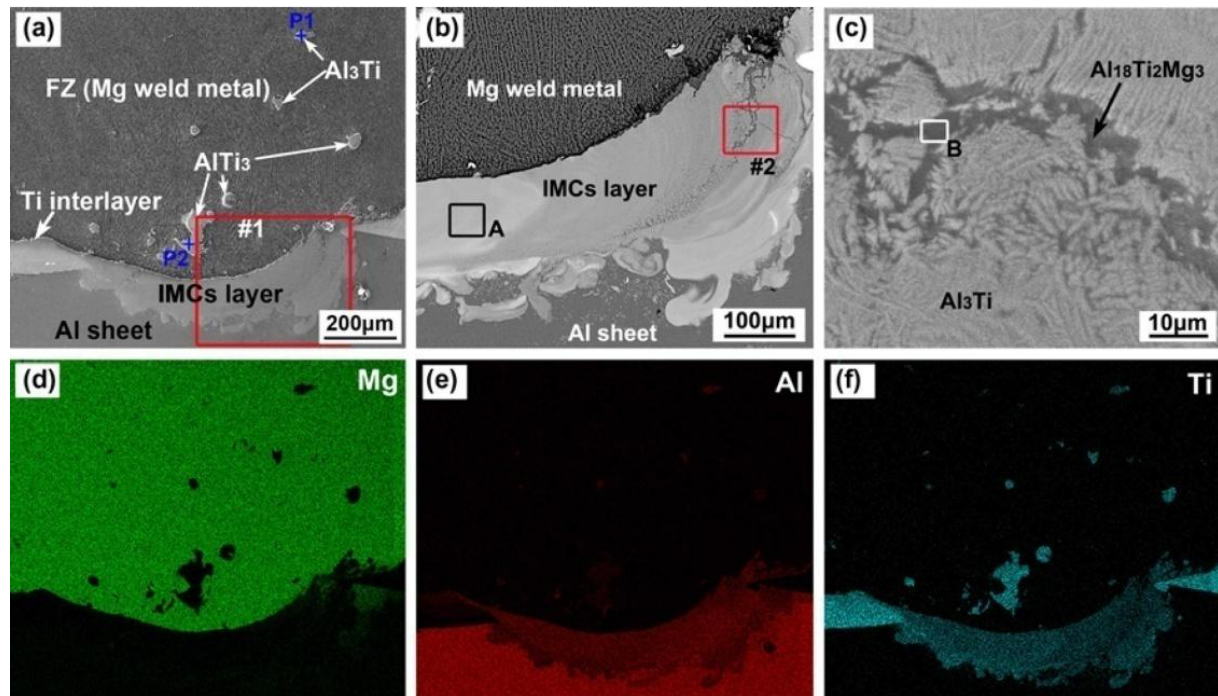
Figure 11. Element distribution maps of the laser welded Al/Mg joint with Ti-foil as interlayer [68]. ( a ) Overview of interfacial layer and the image for distribution maps of major elements; ( b ) details of area #1; ( c ) details of area #2; ( d ) map of element Mg; ( e ) map of element Al; ( f ) map of element